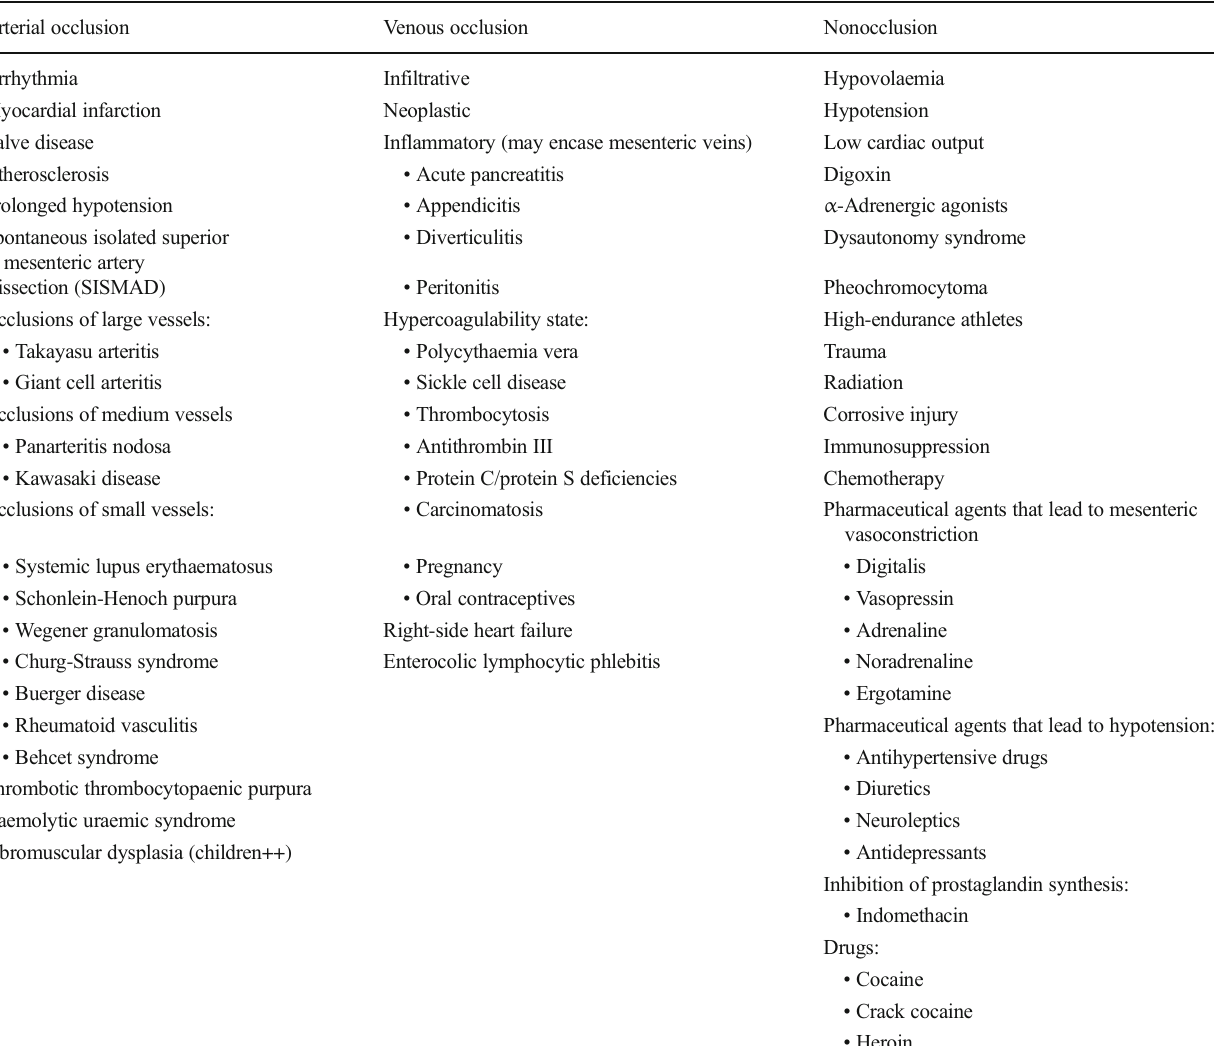
Table 1 Causes of IMA by aetiology Arterial occlusion Venous occlusion Nonocclusion Arrhythmia Infiltrative Hypovolaemia Neoplastic